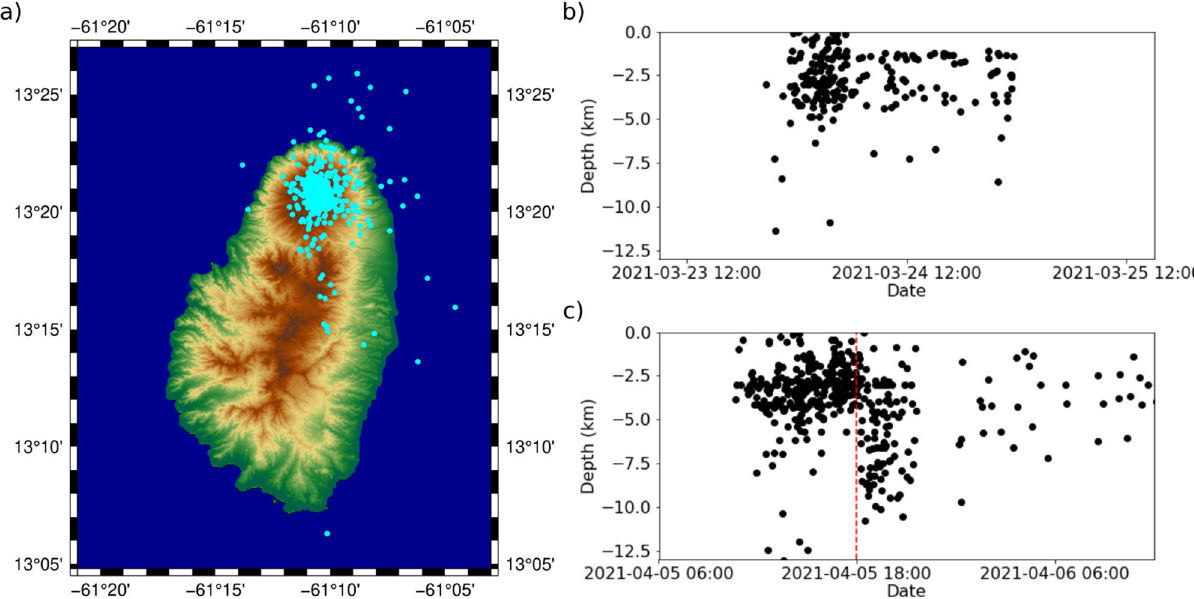
Fig. 3 Seismicity located during 23 – 24 March and 5 – 6 April VT swarms. a Epicentres calculated showing concentric distribution. b Temporal evolution of depths during 23 – 24 March, most seismicity is shallower than 5 km. c Temporal evolution of depths during 5 – 6 April, seismicity is shallower than 5 km until 18:00 UTC on 5 April, when locations transitioned to deeper